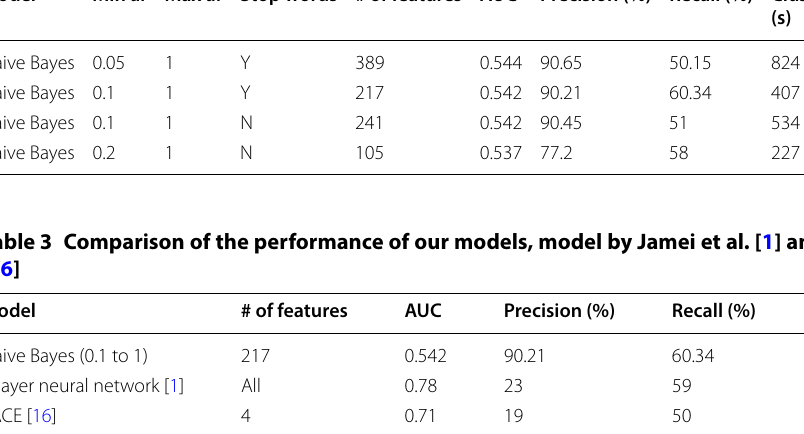
Table 2 Comparison of various NB and DF configurations Model